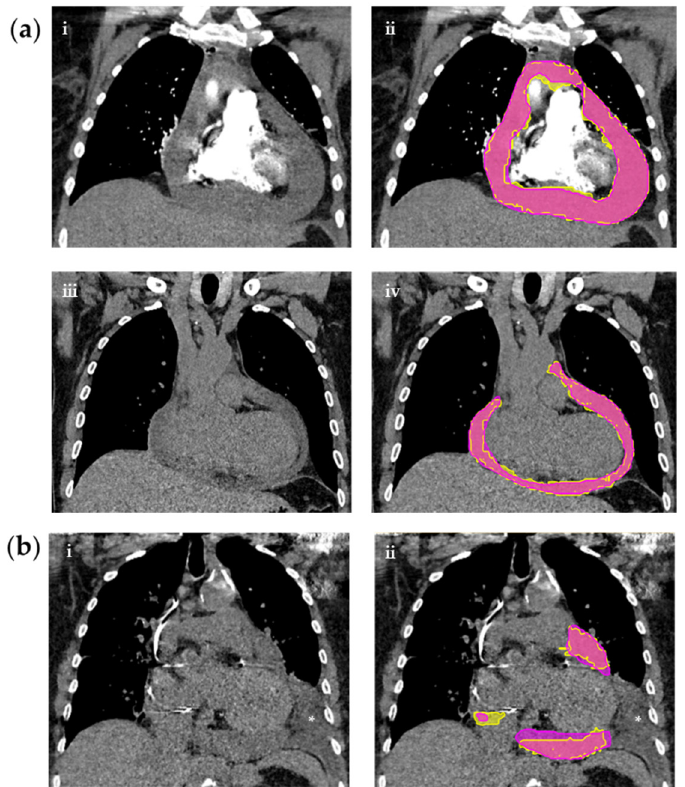
Figure 4. CT chests on the left with corresponding segmentations on the right of three different patients. ( a ) CT studies with or without contrast. (i) shows a contrast enhanced CT with hemoperi- cardium without segmentation masks and (ii) with reference (yellow) and predicted (pink) masks. (iii) shows a non-contrast CT with PEF without masks and (iv) with reference (yellow) and predicted (pink) masks. ( b ) Non-contrast CT study with PEF and adjacent pleural effusion (*) (i) without masks and (ii) with reference (yellow) and predicted (pink) masks.